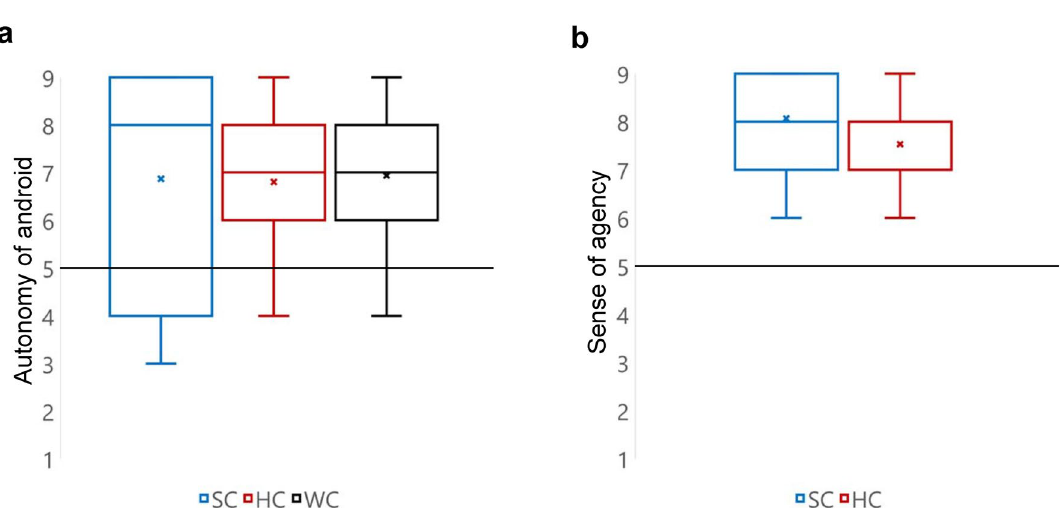
Figure 4. Results of the questions about autonomy of android (“Do you think that the android could think by herself when she spoke?”) and sense of agency (“When you were operating the android, did you feel that it was working because you were operating it?”): ( a ) Autonomy of android. Based on the results of the Wilcoxon rank- sum test with a chance level (5: neither) under each condition, each evaluated value was found to be significantly higher than the chance level. The statistics are listed in Table 2. ( b ) Sense of agency. Based on the results of the Wilcoxon rank-sum test with a chance level (5: neither) under each condition, each evaluated value was found to be significantly higher than the chance level. The statistics are listed in Table